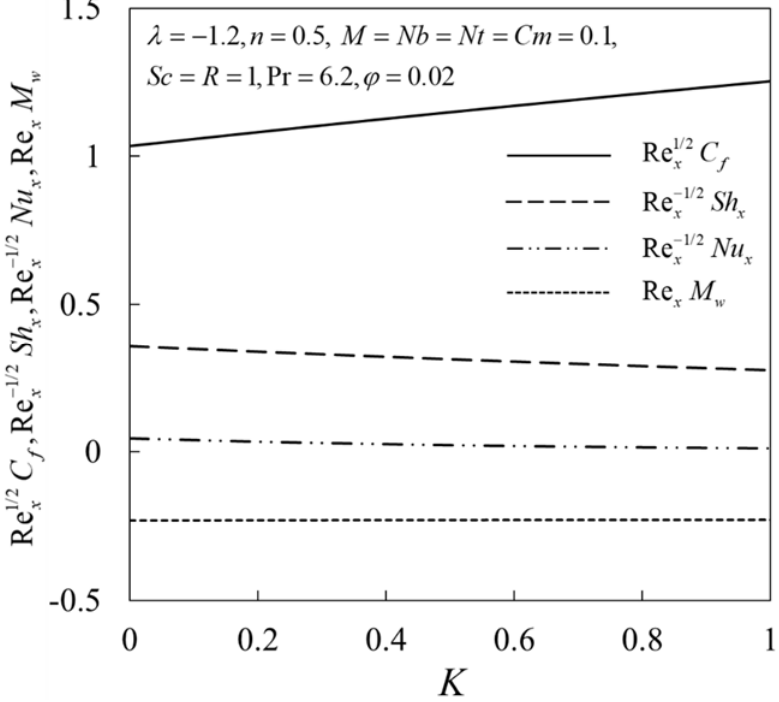
Figure 2. Re (cid:3051) (cid:2869)/(cid:2870) 𝐶 (cid:3033) , Re (cid:3051) (cid:2879)(cid:2869)/(cid:2870) 𝑆ℎ (cid:3051) , Re (cid:3051) (cid:2879)(cid:2869)/(cid:2870) 𝑁𝑢 (cid:3051) , and Re (cid:3051) 𝑀 (cid:3050) vs. 𝐾 . Figure 2. Re 1/2 x C f , Re − 1/2 x Sh x , Re − 1/2 x Nu x , and Re x M w vs. K